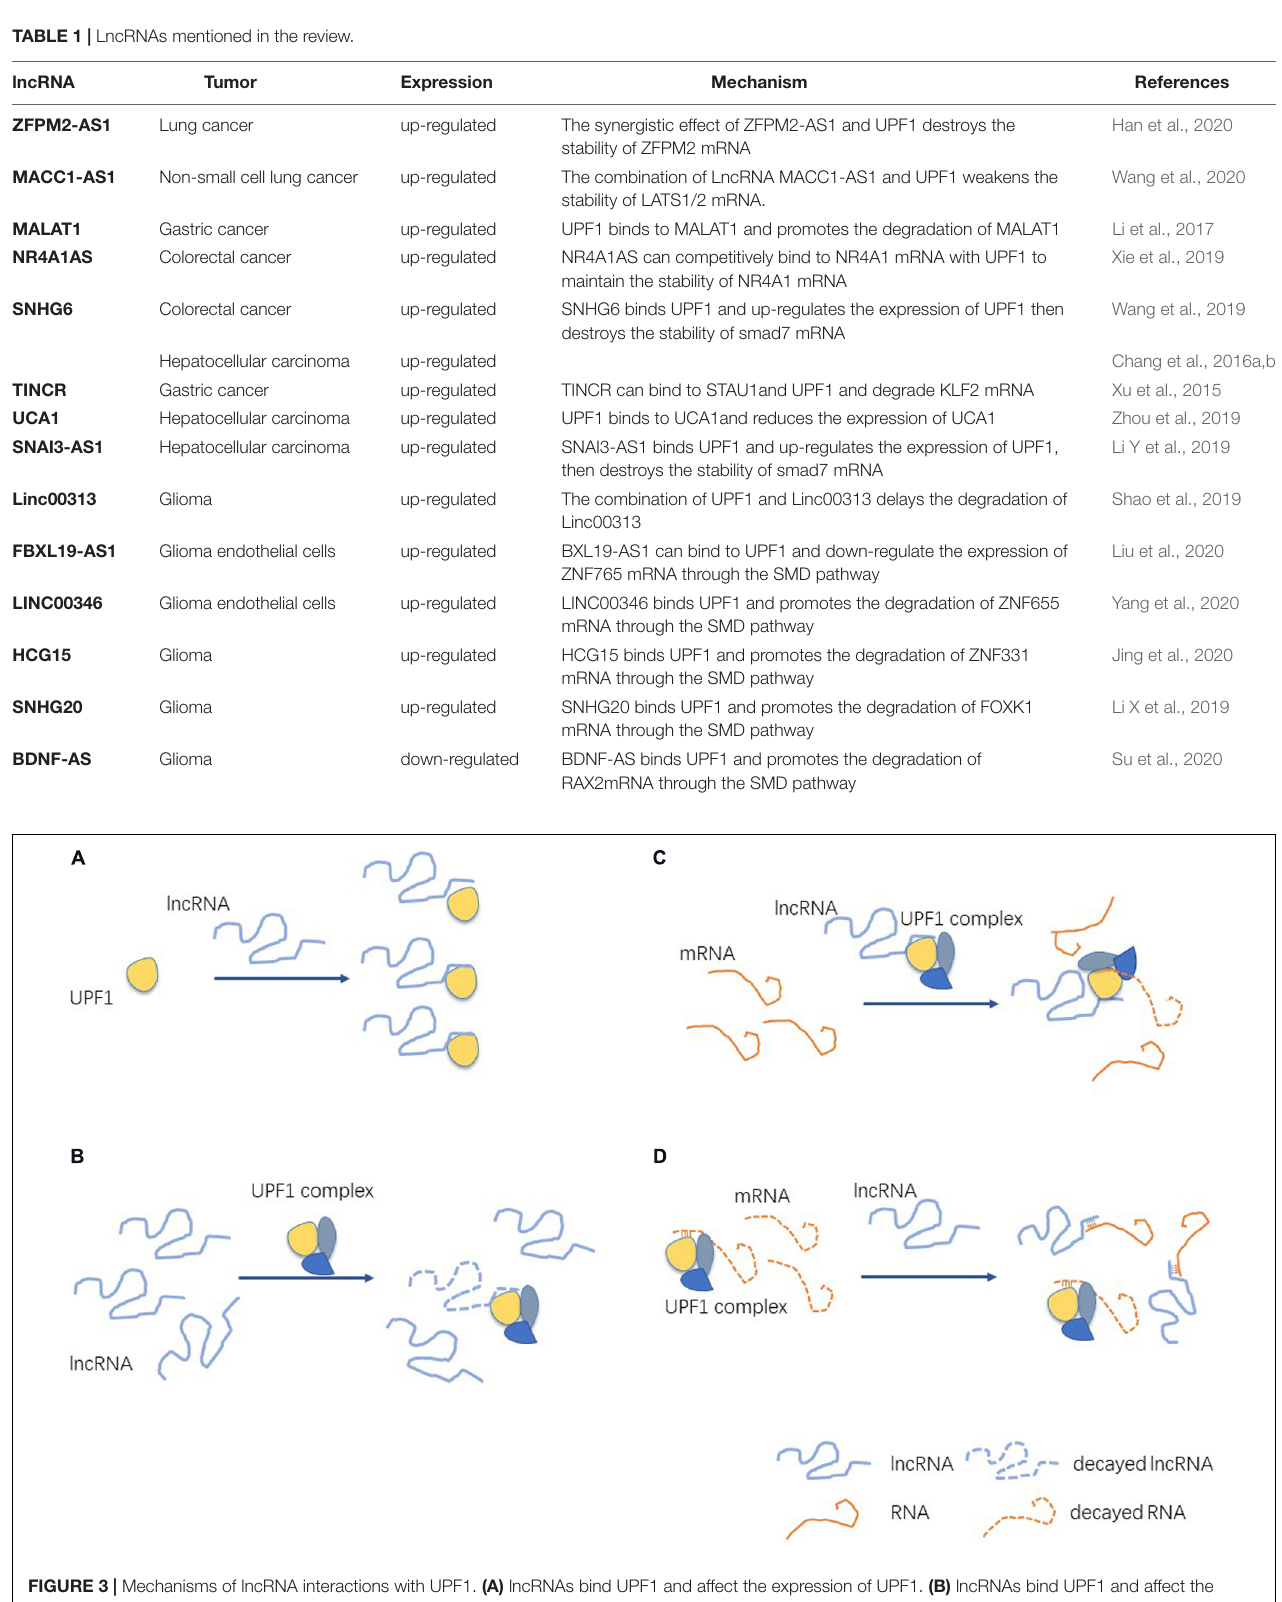
Frontiers in Genetics |